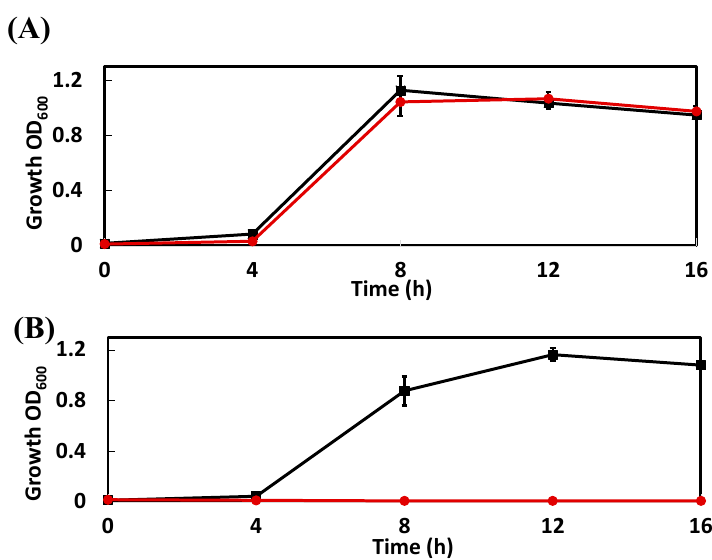
Figure 6. Growth of strain LLC-1 and P. putida NBRC 14164 in culture medium containing benzoylformic acid ( A ) and ( R.S )-mandelic acid ( B ). The circles (red) represent the growth profile of strain LLC-1 and squares (black) represent the growth profile of P. putida NBRC 14164. Experiments were performed in triplicates, and standard deviations are displayed as error bars.